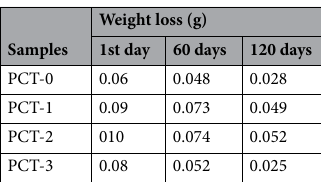
Table 4. Weight loss of PVA/CMC/TUR films at different